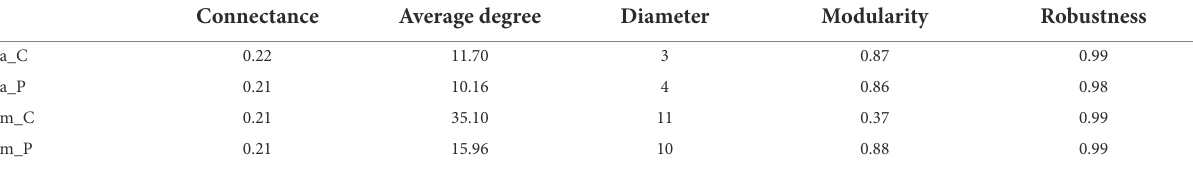
TABLE 1 The parameters statistics for the microbial co-occurrence networks.